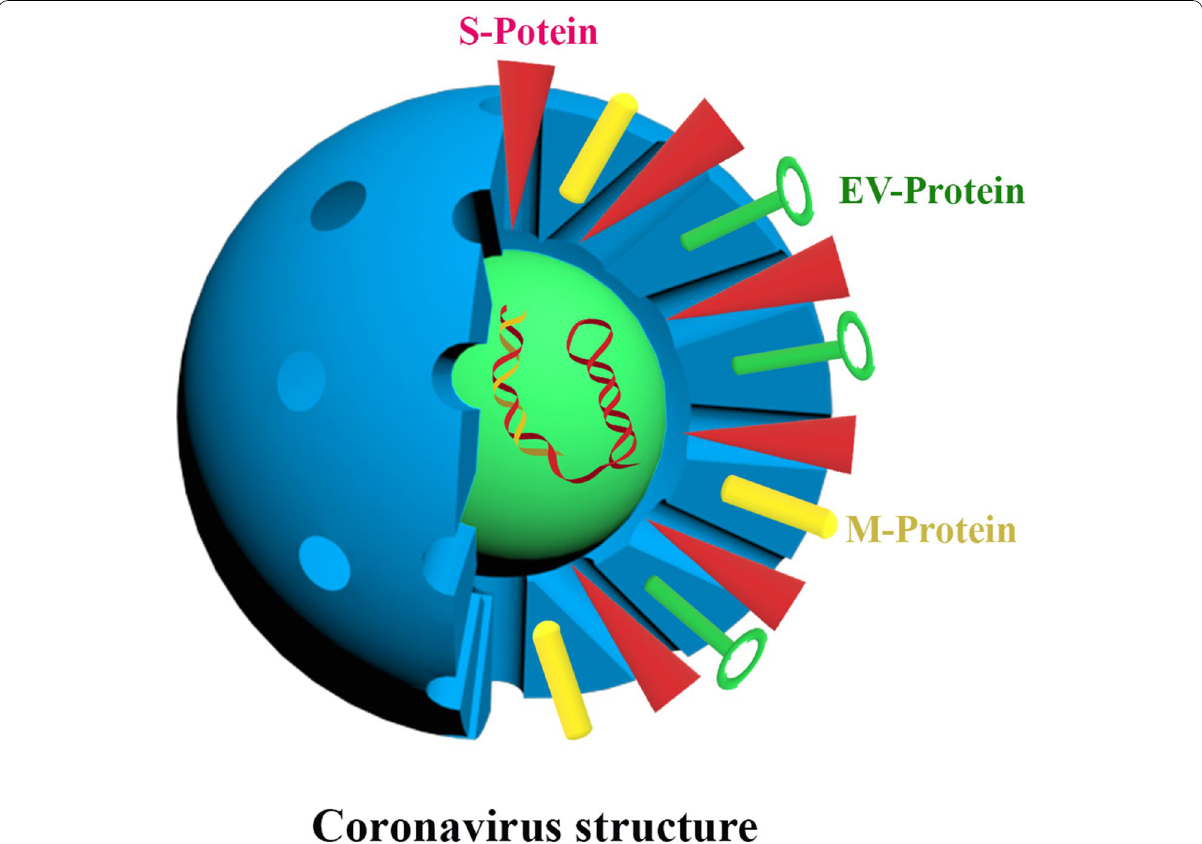
Fig. 1 Coronavirus structure. In this structure, surface proteins (The spike protein (S-Protein), Envelope Protein (EV-Protein) and Membrane Protein (M-Protein), nucleotides and crowns of this virus are shown. The corona crown gives this type of virus a unique structure that distinguishes it from other